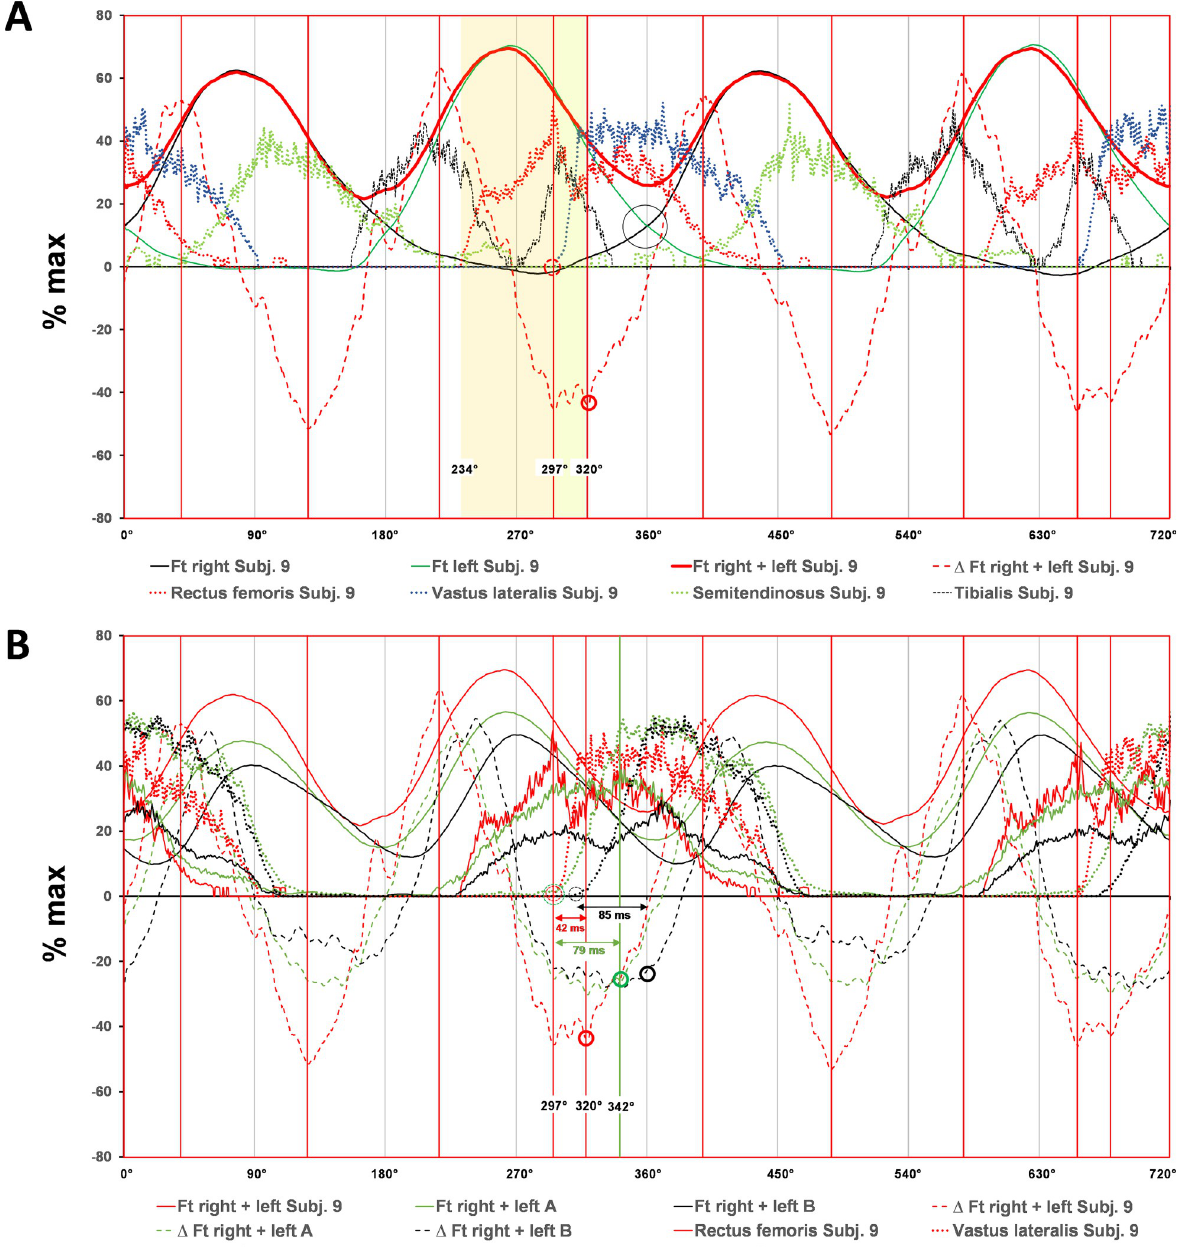
Fig 6. Recruitment pattern of RF/VL at the transition from hip flexion to knee extension in CP-tests. (A, B) Bi-pedal crank force (Ft right and Ft left), total propulsive force (Ft r+l), rate of force development ( Δ Ft), and averaged EMG across two pedal cycles at the MLSSw for subject 9 (red) (A) and for subject 9 vs highly trained (group A) and trained (group B) athletes (B) . Vertical lines and circles (red = subject 9, green = group A, grey/black = group B) show reversal points of Δ Ft (begin of force development during knee extension). Broken circles (red = subject 9, green = group A, black = group B) indicate the beginning of VL activation. Note the delayed VL activation (297˚-320˚) after termination of RF activity for hip flexion (234˚-297˚) in Q4 (A) . Here, the RF likely operates together with the VL as a knee extensor. After onset of activation, the VL/ RF-induced change in Δ Ft (electromechanical delay, EMD) starts after 42 ms in subject 9, after 79 ms in group A and after 85ms in group B (B) . A major difference between group A/subject 9 and group B is the more intense RF activation and the rapid onset of VL activity. Here, the pretension of the RF during hip flexion and subsequent strong and fast knee extension together with the other thigh extensors is the characteristic activation pattern of highly endurance trained cyclists (B) . For detailed description of data analysis and parameter definitions see Methods and S1 Fig.